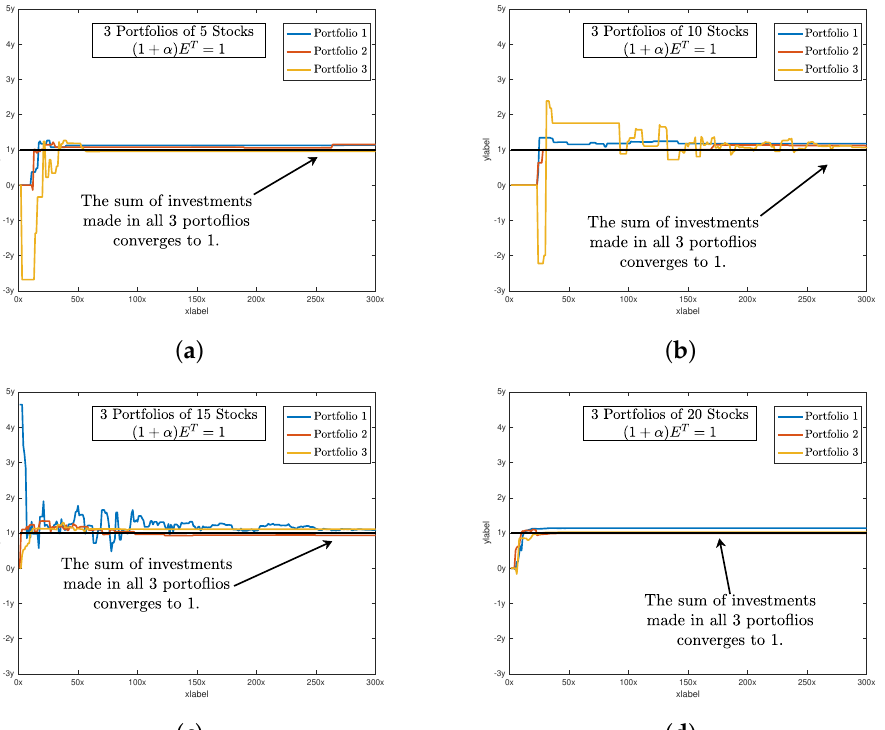
Figure 8. It shows that as the portfolio selection problem converges toward the optimal solution, the sum of normalized investment ( 1 + α ) E ≈ 1. There are some spikes in the beginning; however, all the particles of the respective portfolio converge to 1. ( a ) shows the convergence of normalized investment ( 1 + α ) E ≈ 1 of 5 stocks. Likewise, ( b ) shows the convergence of normalized investment of 10 stocks. And finally, ( c , d ) shows the convergence of normalized investment of 15 and 20 stocks